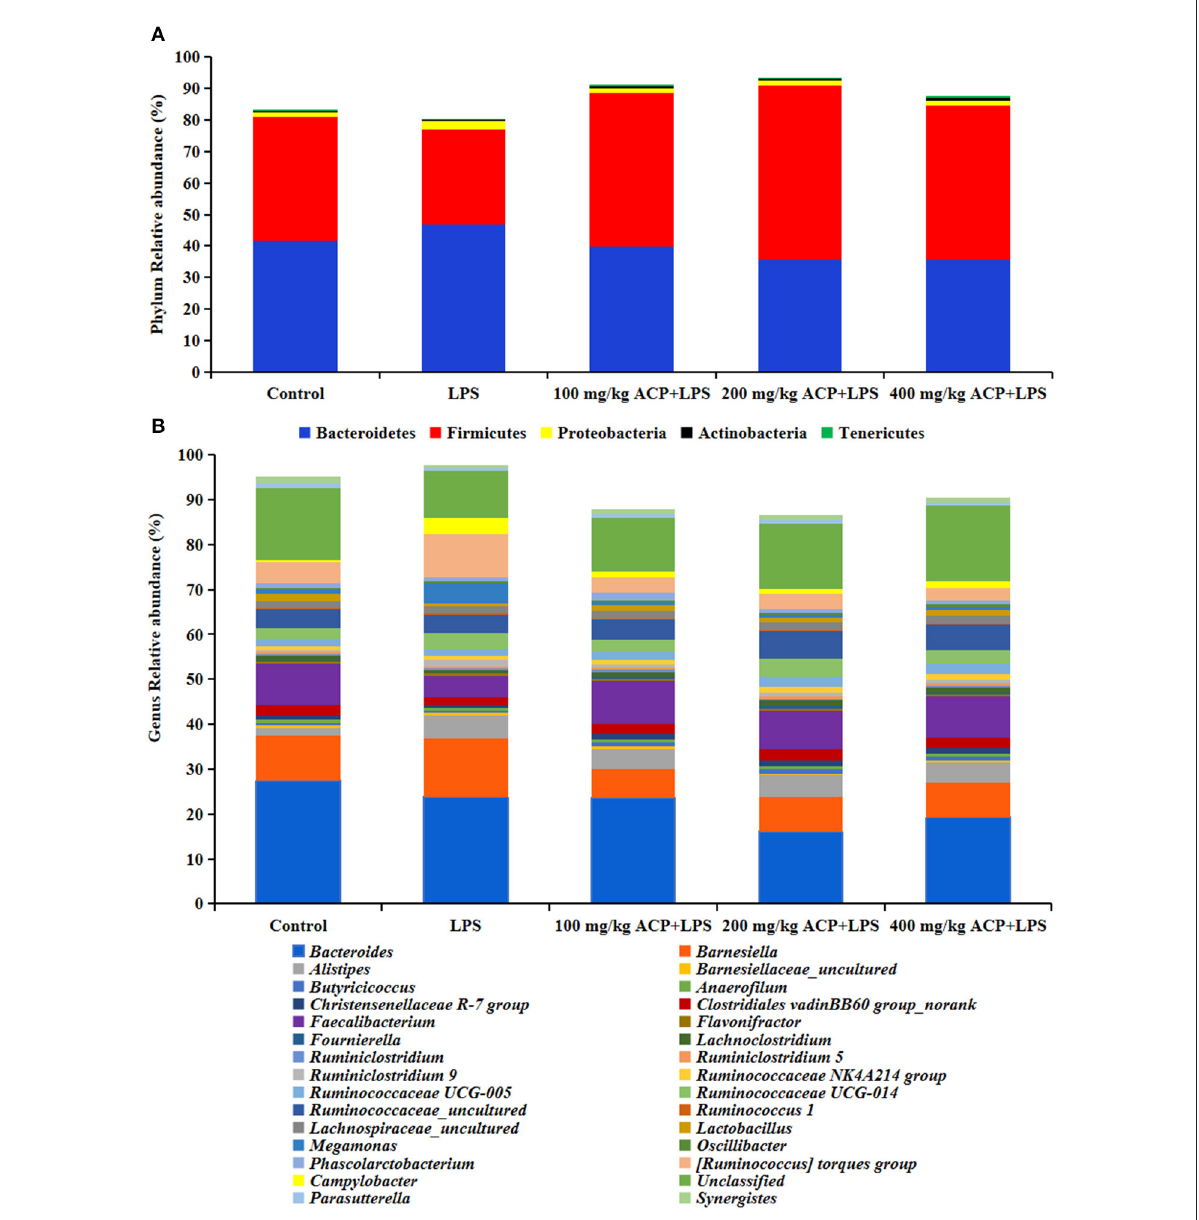
FIGURE2 Effects of Antrodia cinnamomea polysaccharide on microbiome composition in the cecum of slow-growing broilers challenged with LPS. (A) Composition and distribution of the microbiota at the phylum level. (B) Composition and distribution of the microbiota at the genus level. Values are means of 6 replicates per treatment. LPS, Lipopolysaccharide; ACP, Antrodia cinnamomea polysaccharide; Control, basal diet group; LPS, basal diet + LPS stress group; 100 mg/kg ACP + LPS, basal diet + LPS stress + 100 mg/kg ACP group. 200 mg/kg ACP + LPS, basal diet +